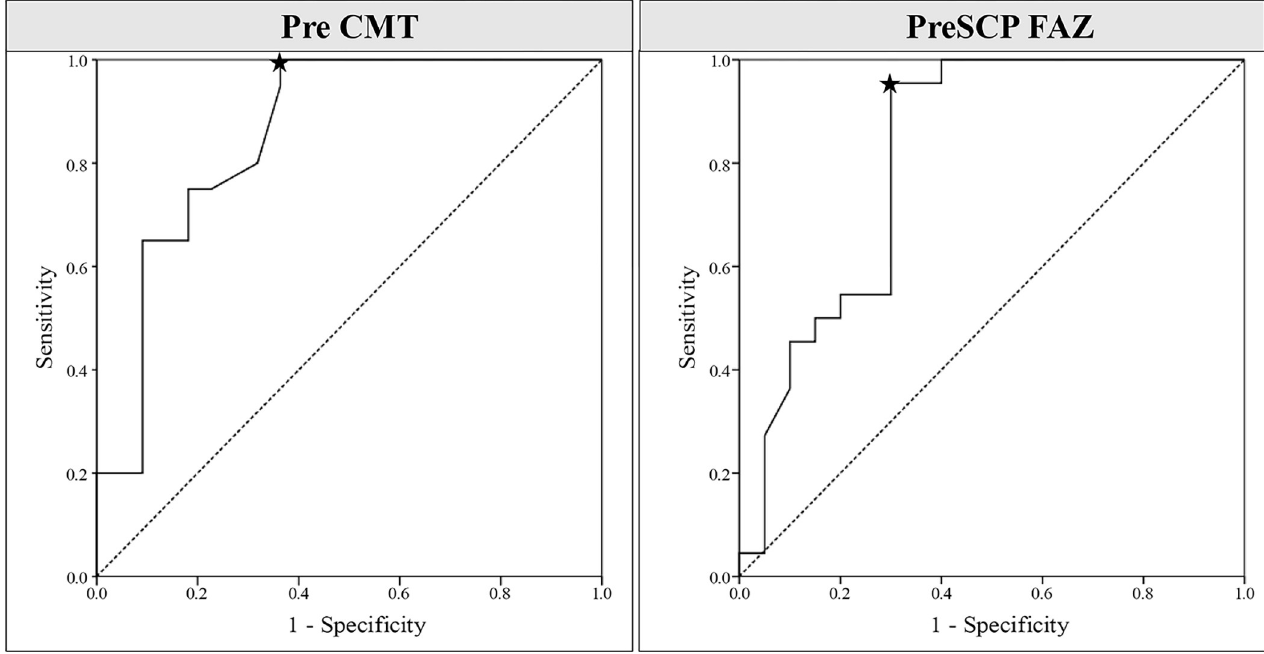
Fig 3. Receiver operating characteristic curves of baseline CFT and SCP-FAZ. The area under the curve was 0.858 for CFT and 0.816 for SCP FAZ. The cutoff value (asterisk) using the Youden index was 139.5 μ m for CFT and 0.265 mm 2 for SCP FAZ. CFT, central foveal thickness; SCP, superficial capillary plexus; FAZ, foveal avascular